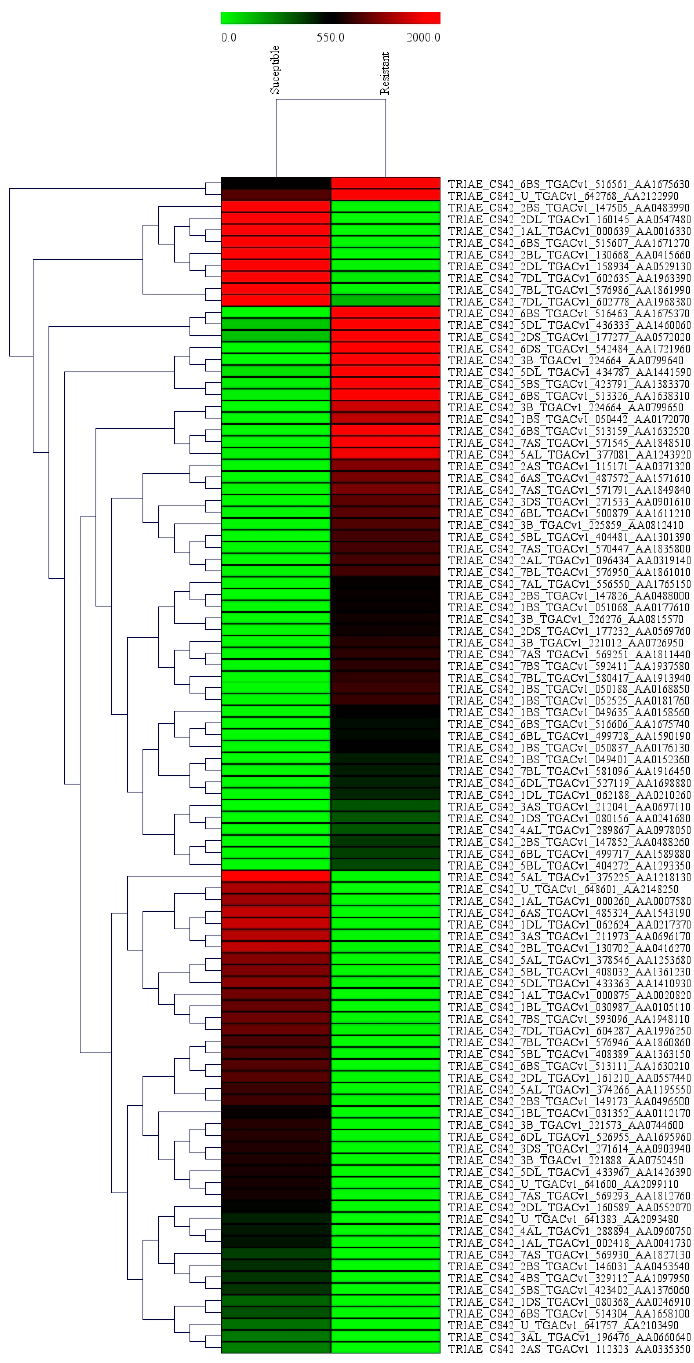
Figure 3. A Heat map of differentially expressed genes of T . indica . The color codes (red for upregulated genes and green for downregulated genes) are shown to indicate the relative expression of DEGs.